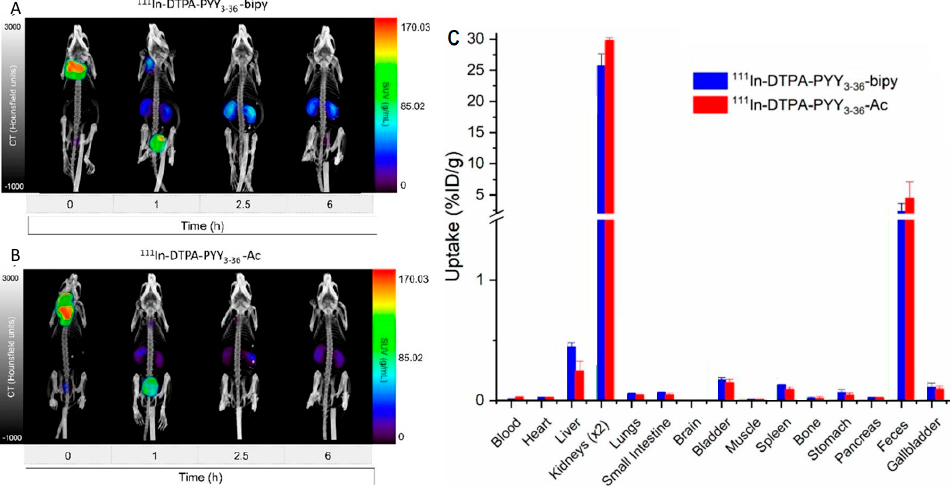
Figure 7. Coronal view of SPECT/CT scans after subcutaneous administration of ( A ) 111 In-DTPA-PYY3–36-bipy and ( B ) 111 In-DTPA-PYY3–36-Ac in mice (n = 3). ( C ) Biodistribution (%ID/g) of radioconjugates 24 h post-injection. Reprinted with permission from Kalomoiri et al. (2020) [108].